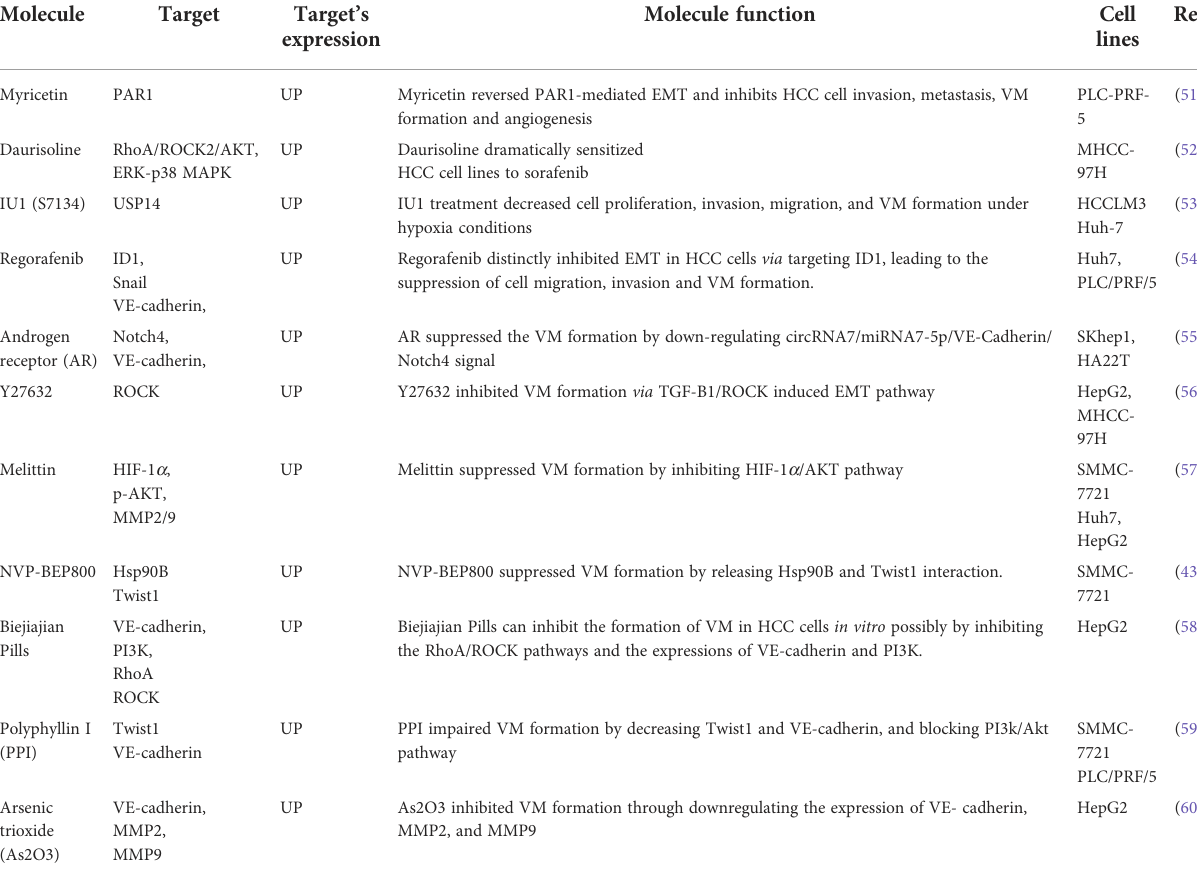
TABLE 1 The novel targets and promising drugs to reverse resistance by inhibiting VM formation.